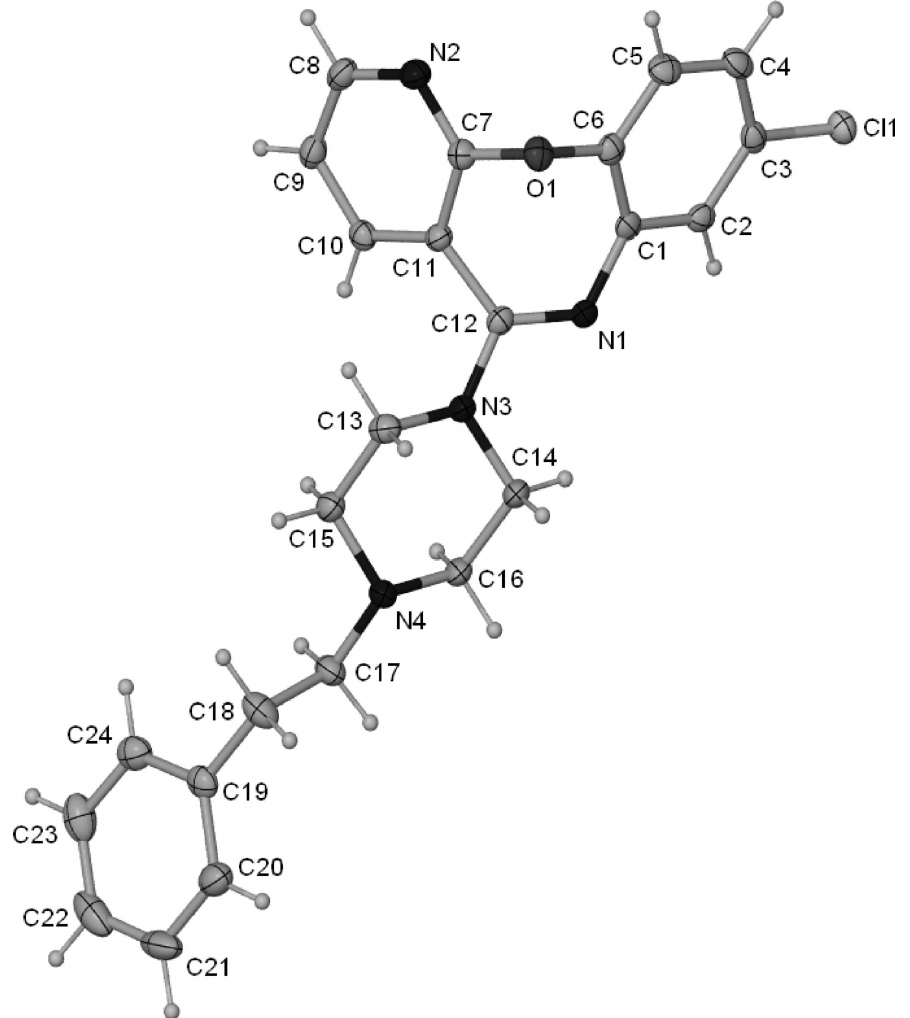
Figure 1 Molecular diagram of one of the crystallographically independent molecules of the title compound. Displacement ellipsoids are drawn at the 50% probability